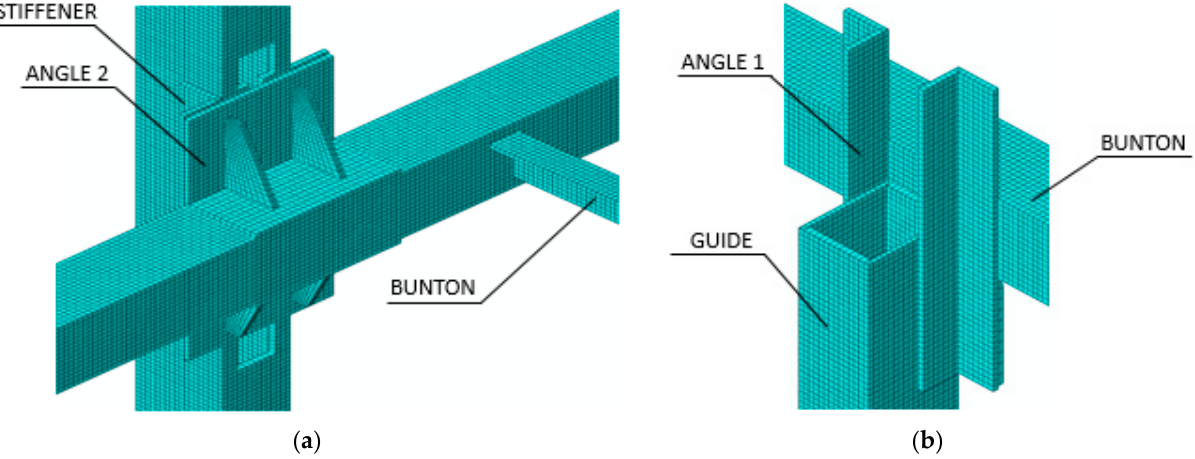
Figure 6. View of the guide-to-bunton connections model: ( a ) joint at mid-point of guide; ( b ) joint at the end of the guide.